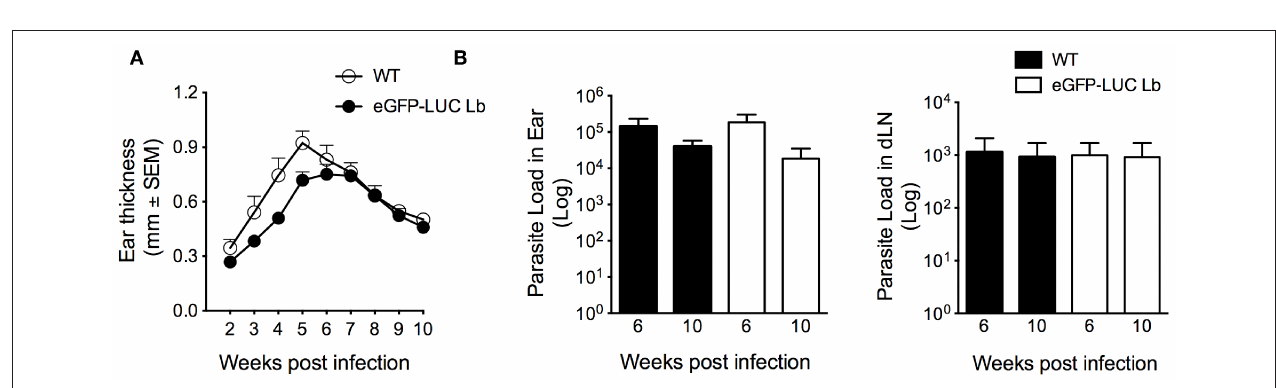
FIGURE 4 | In vivo infectivity of transgenic L. braziliensis co-expressing eGFP and Luciferase. (A) BALB/c mice ( n = 6) were infected with enriched metacyclics of WT or eGFP_LUC Lb (10 5 ) and lesion development was measured weekly. (B) Parasite load was determined at the infection site and at the dLN by limiting dilution analysis. Data (mean ± SEM) are from a representative experiment, performed with 6